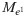
Cross-experiment data pooling leads to network inference errors.Illustration of a simple hypothetical causal model Mc with three observable entities (Vi, Vj, and Vk. Two different interventional experiments are depicted: experiment Me1 involves intervention I1, and experiment Me2 involves intervention I2. Pooling measurements from the two experiments can cause two types of network inference errors: false positive edge (shown in (a) as a red arrow between Vi and Vj), and false negative edges (shown in (b) as blue arrows between Vi and Vk and between Vj and Vk).